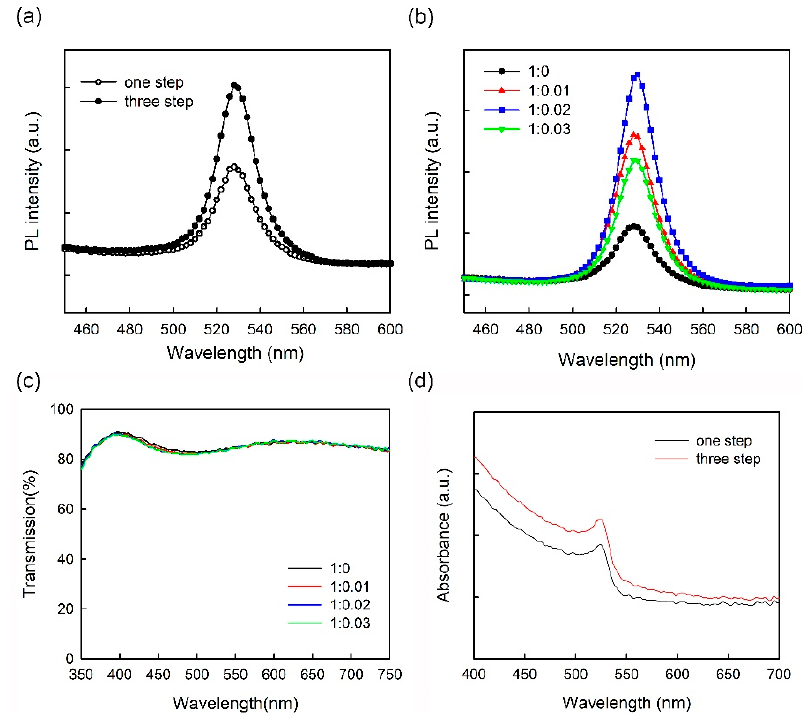
Figure 4. PL spectra of ( a ) one-step and three-step coated CH 3 NH 3 PbBr 3 films on the pure